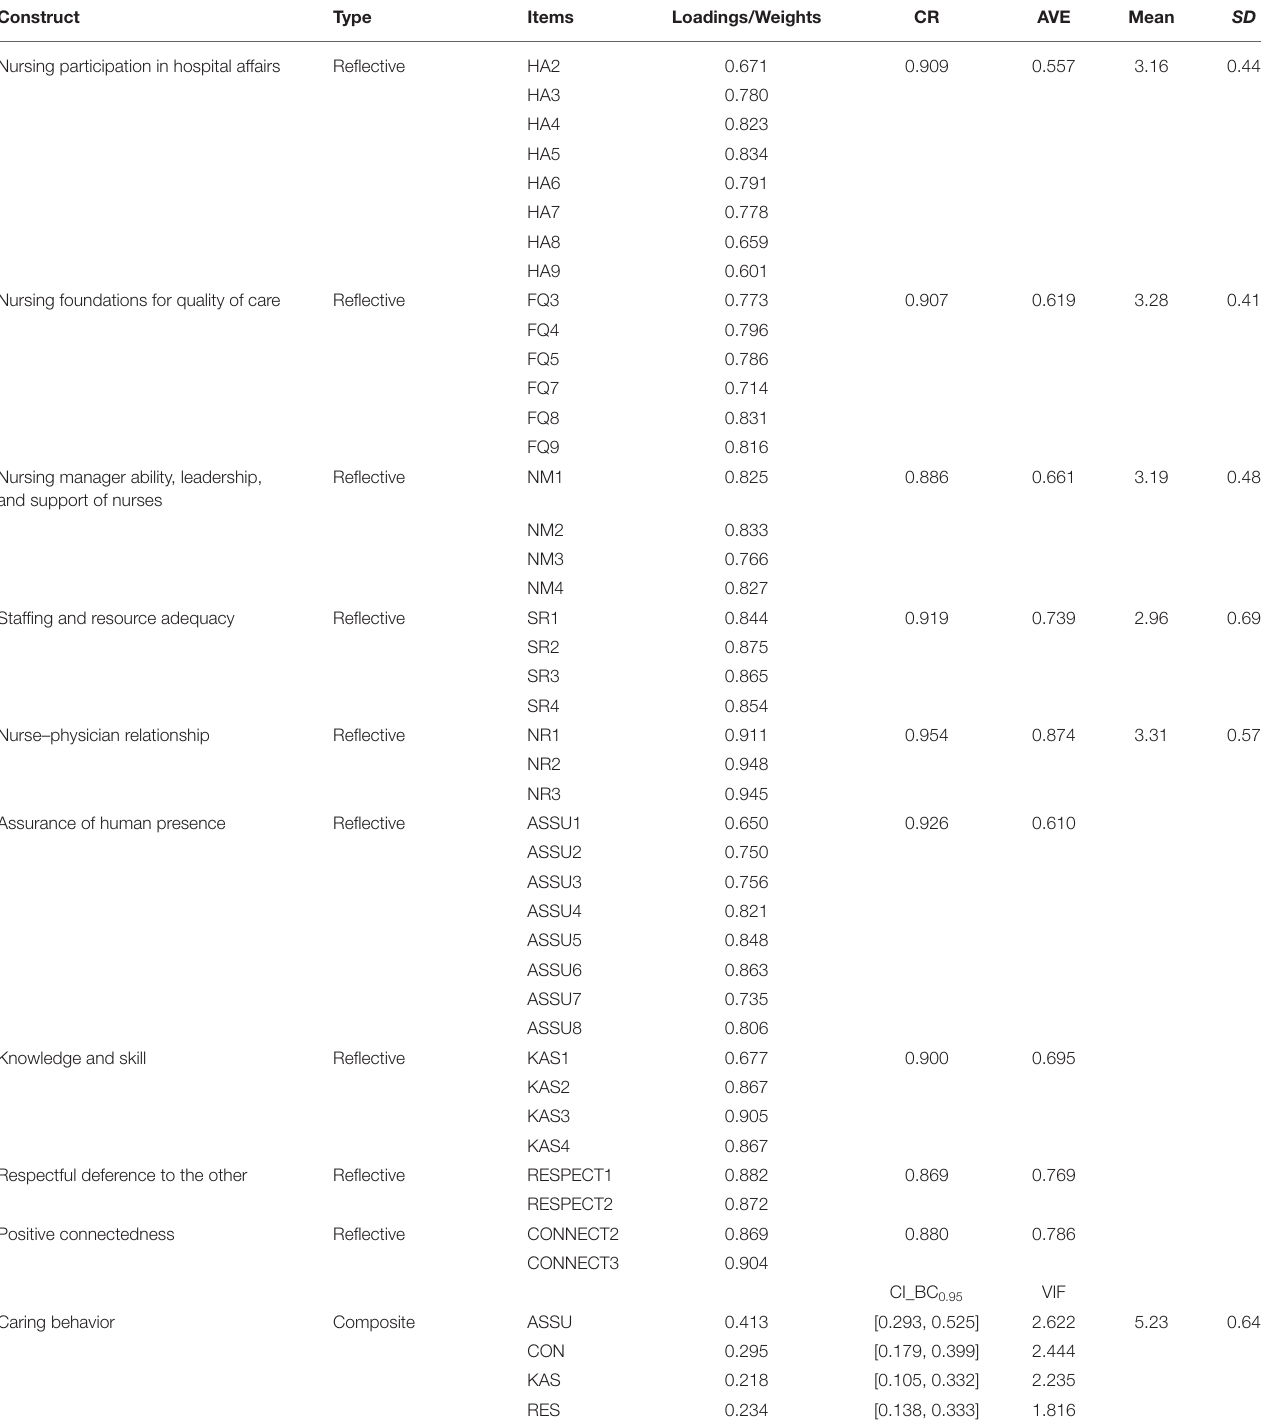
TABLE 1 | Results: assessment of reflective measurement and composite